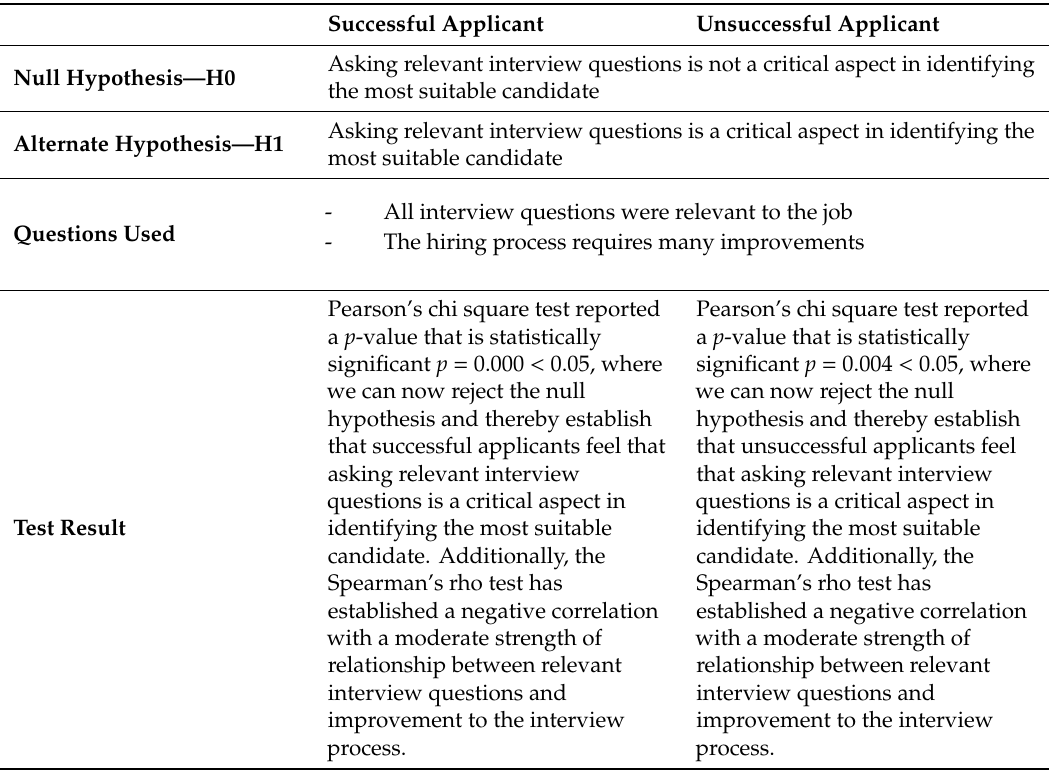
Table 5. Applicant Perspective Hypothesis 3—Relevant Interview